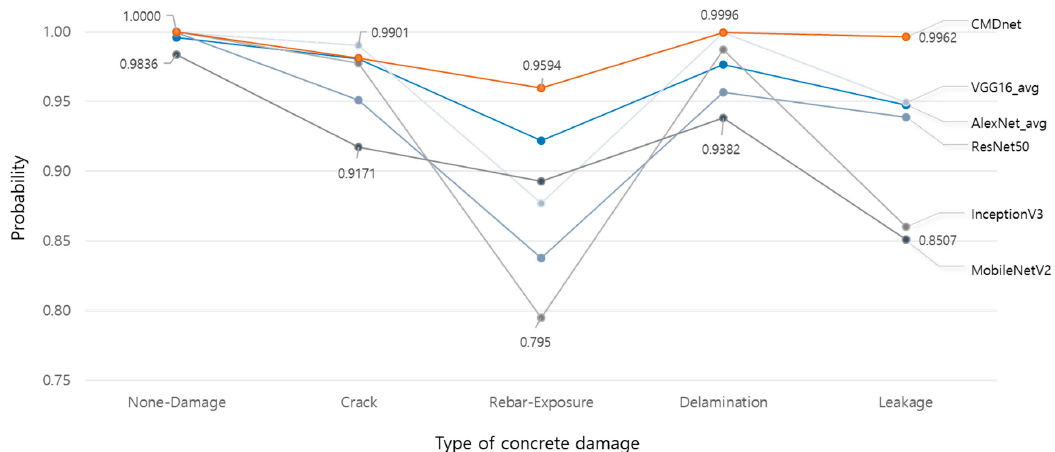
ff erent models. Materials 2020 , 13 , x FOR PEER REVIEW